Question: In one sentence, what is this figure communicating?
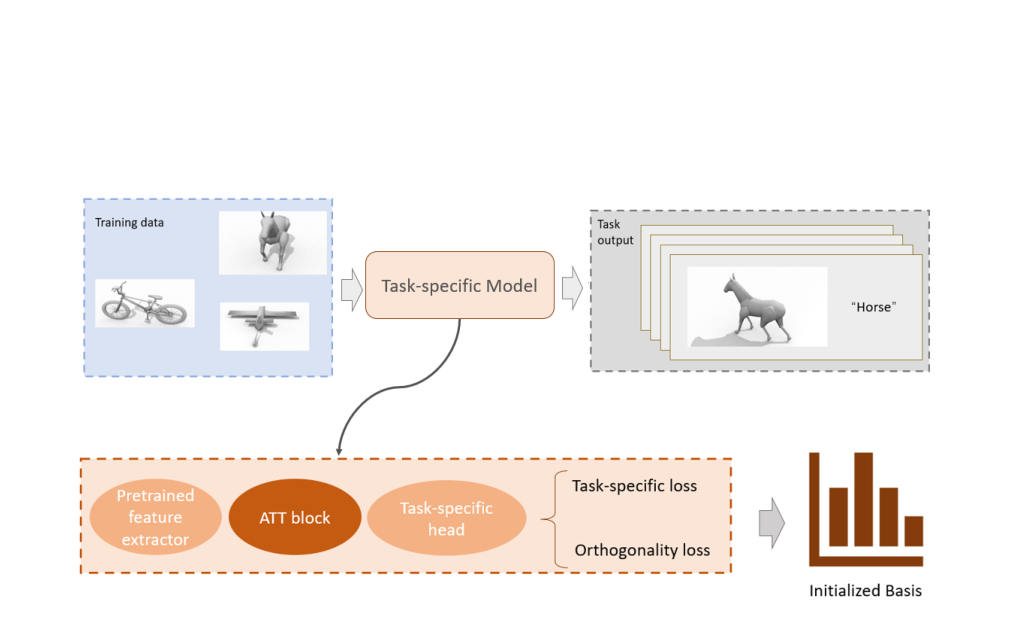
Answer: Whole training process for basis initialization net. Concretely, we train the model like classical machine learning training process and add a small module (attention block) to extract the processed weights which then become the initialized basis of EM algorithm.